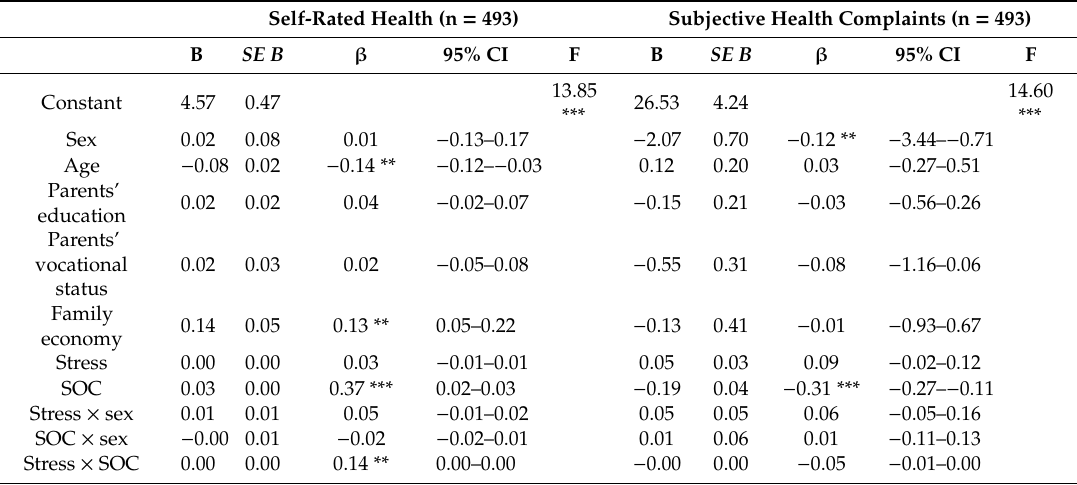
Table 5. Summary of the hierarchical regression analysis for variables associated with self-rated health and subjective health